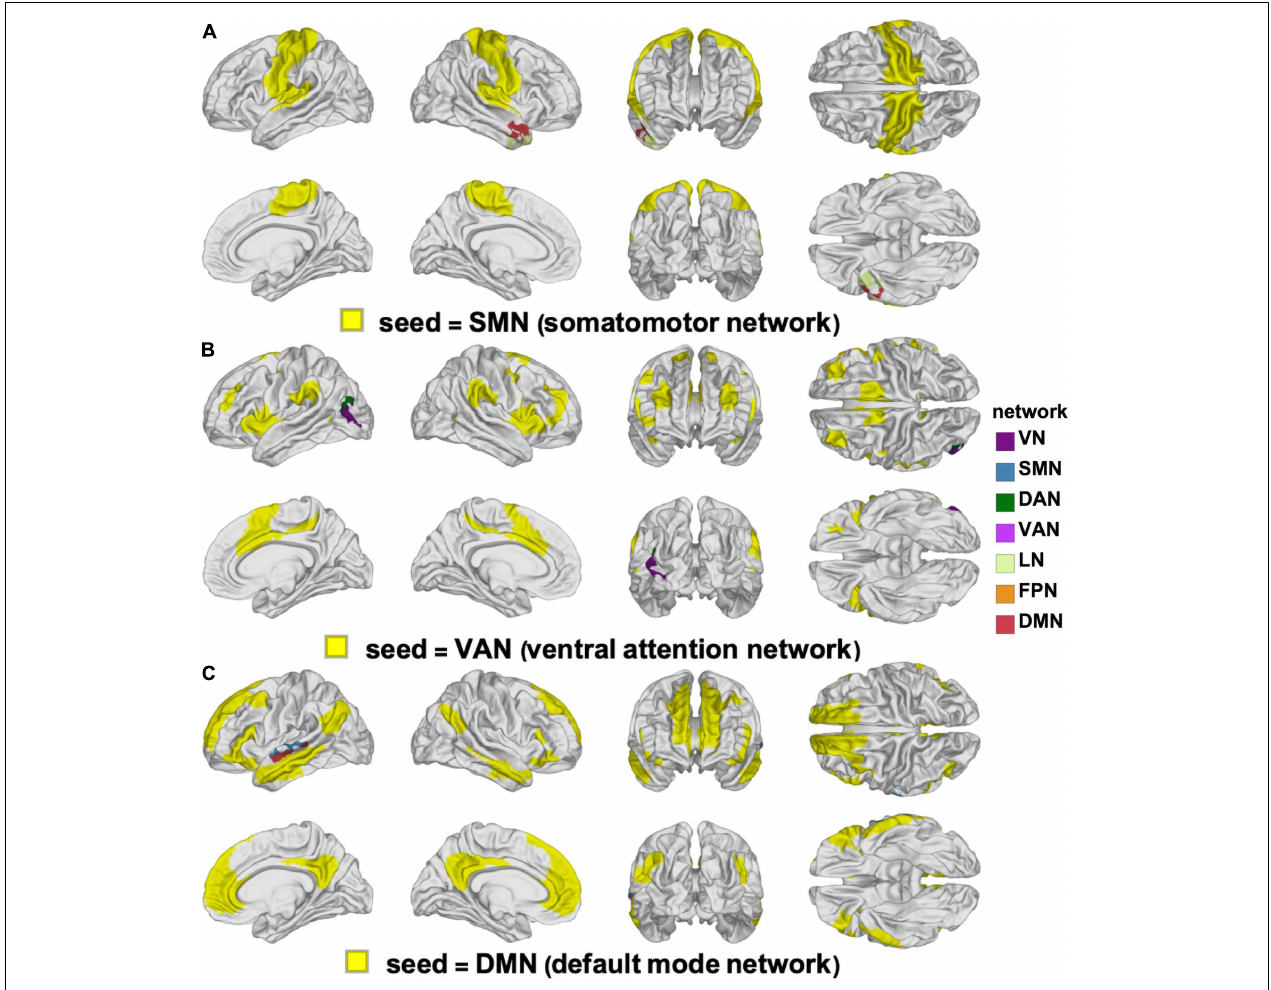
FIGURE 3 | Clusters of statistically significant FC changes that differ significantly between YAs and OAs. In each panel, the seed RSN is painted in yellow and the significant clusters are painted using the color(s) of the RSN(s) with which they overlap, following the color scheme of Yeo et al. (2011), see also Figure 2 . The seed networks are the SMN (A) , VAN (B) , and DMN (C) . No significant clusters were found for the DAN, FPN, LN, or VN. DAN, dorsal attention network; DMN, default mode network; FC, functional correlation; FPN, frontoparietal network; LN, limbic network; OA, older adult; RSN, resting state network; SMN, somatomotor network; VAN, ventral attention network; VN, visual network; YA, young